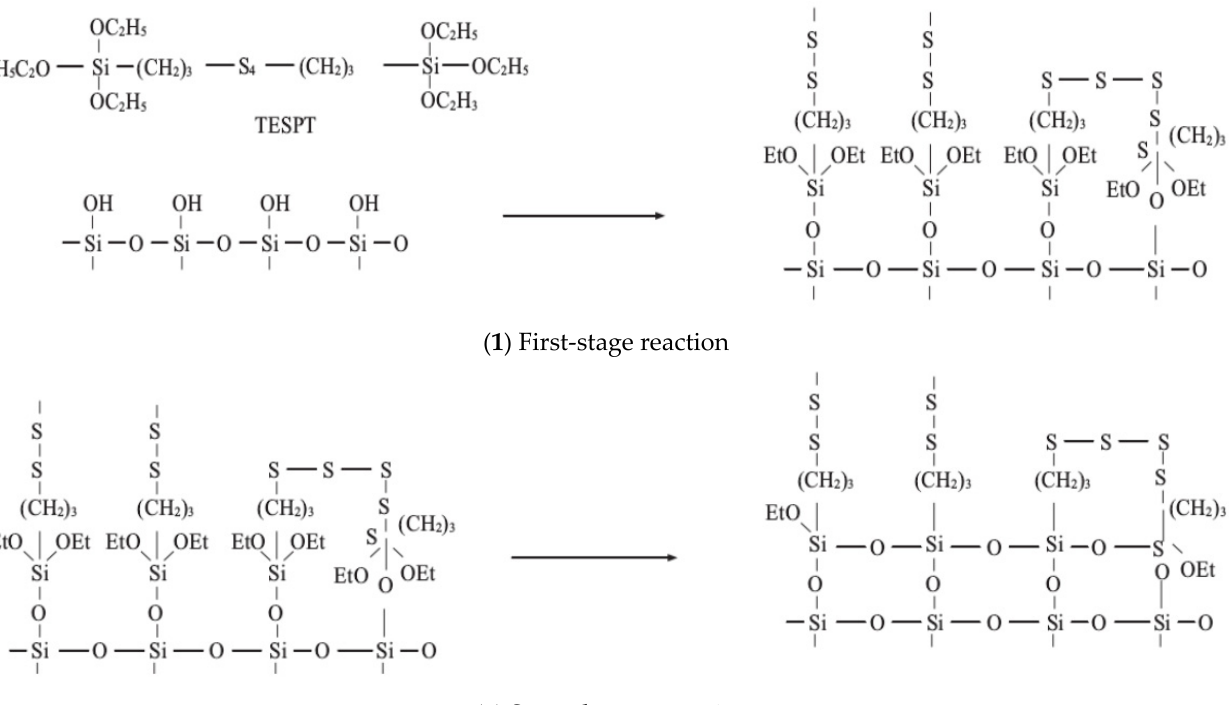
Figure 4. The silanization reaction.